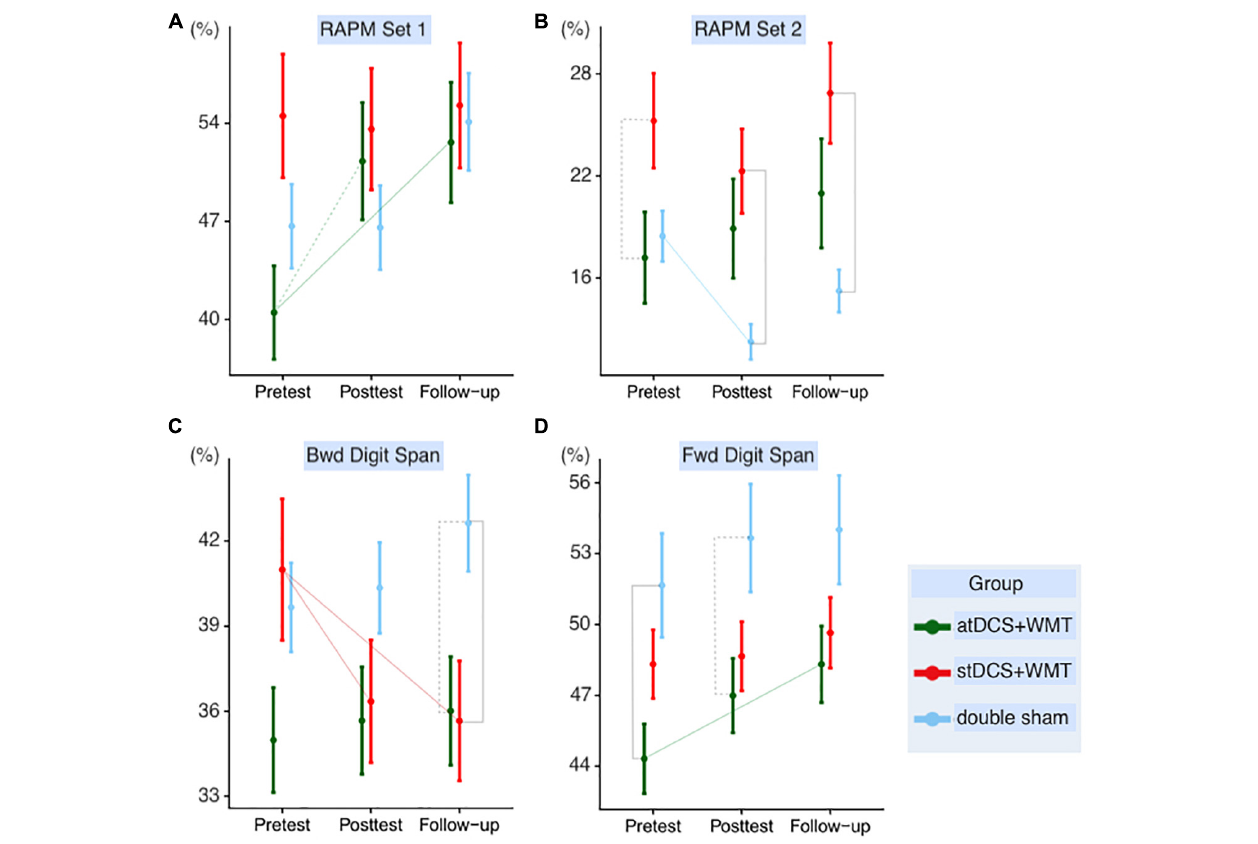
FIGURE 3 | Fitted data representation of group × session interaction for each outcome. The vertical axis represents the percentage of hits regarding the total possible hits. Segments represent the 95% CIs. Solid lines represent statistically significant differences ( p < 0.05), while dashed lines represent marginally significant results ( p < 0.1) supported by Bayesian posterior probabilities (PP ≥ 0.95). RAPM_set 1 (A) ; RAPM_set 2 (B) ; backward Digit Span (C) ; forward Digit Span (D) . atDCS, active tDCS; stDCS, sham tDCS; RAPM, Raven Advanced Progressive